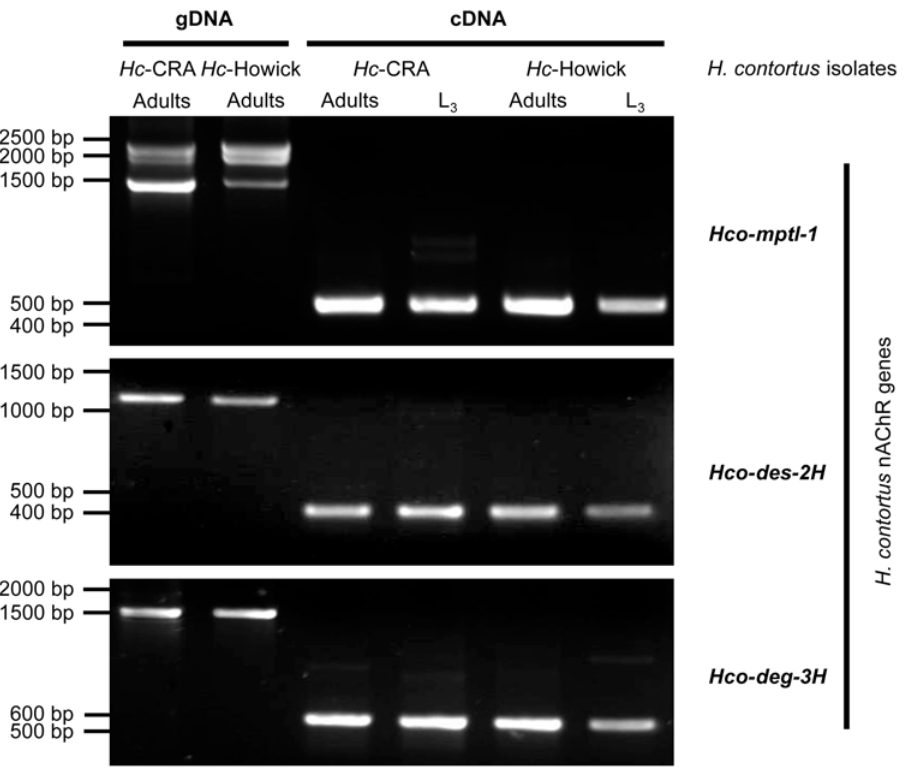
Figure 2. Expression of DEG-3 subfamily members in Haemonchuscontortus . Hco-mptl-1 , Hco-des-2H and Hco-deg-3H are expressed in adult as well as L 3 -larvae stages of both the Hc -CRA and Hc -Howick parental reference isolates (AAD naı¨ve) as determined by reverse transcriptase PCR. Genomic DNA (gDNA) was included as a control.